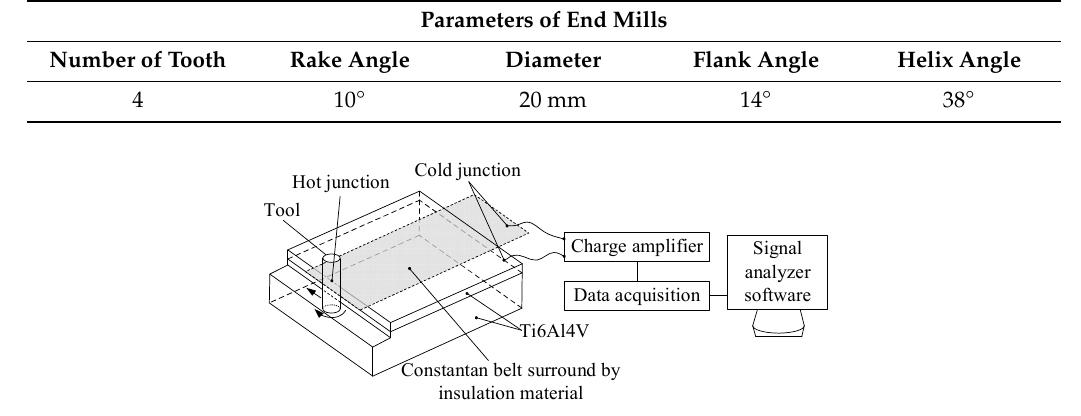
Table 1. Tool parameters for experiment [34].